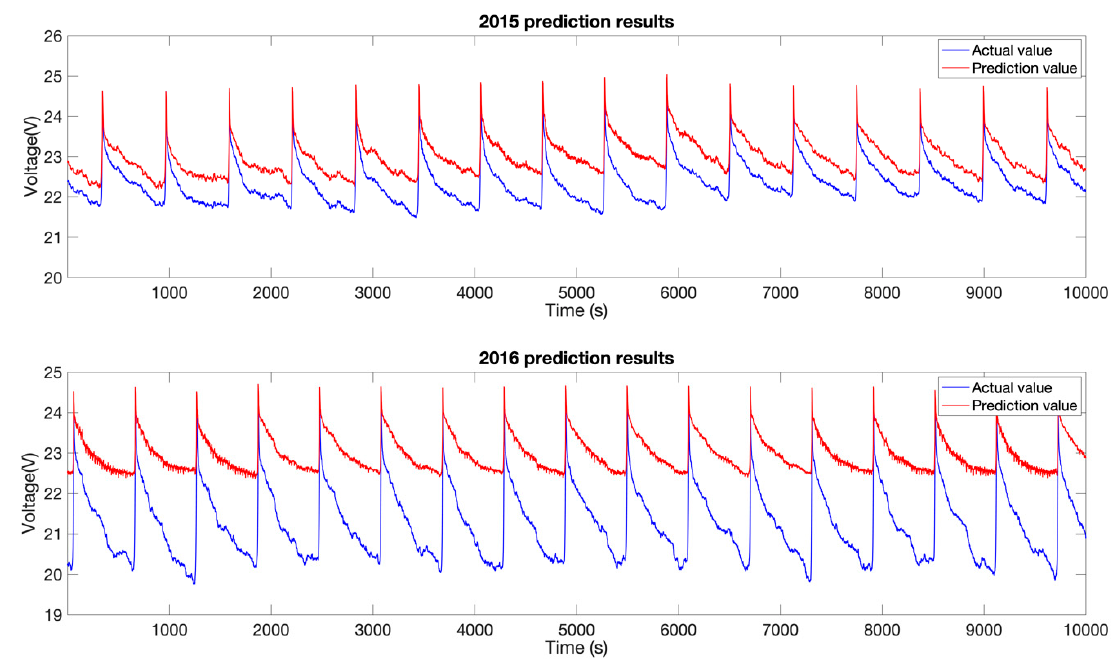
Figure 8. Partial prediction results in 2015 (above) and 2016 (below).